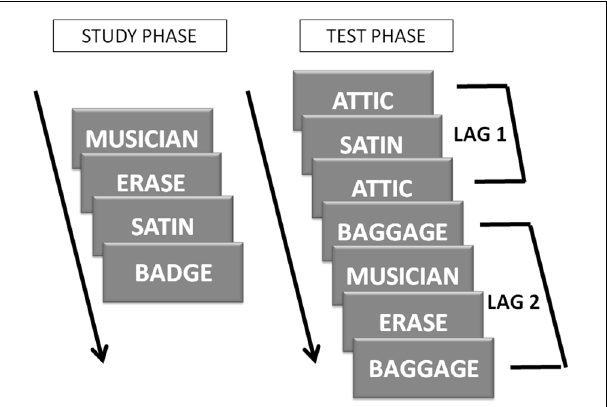
FIGURE 2 | Recollection training design. During the study phase, words were presented one at a time in the middle of the screen. During the test phase studied words and new words were presented. New words were repeated at two lag intervals. All participants started at lags 1 and 2, which is schematically represented